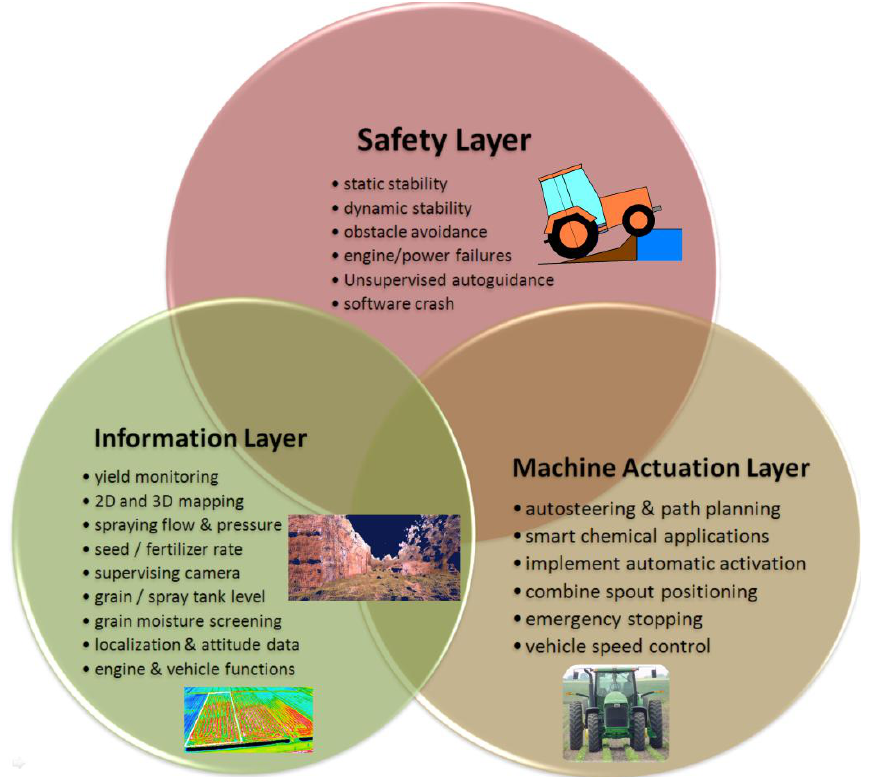
Figure 3. Three-layer task classification for intelligent agricultural